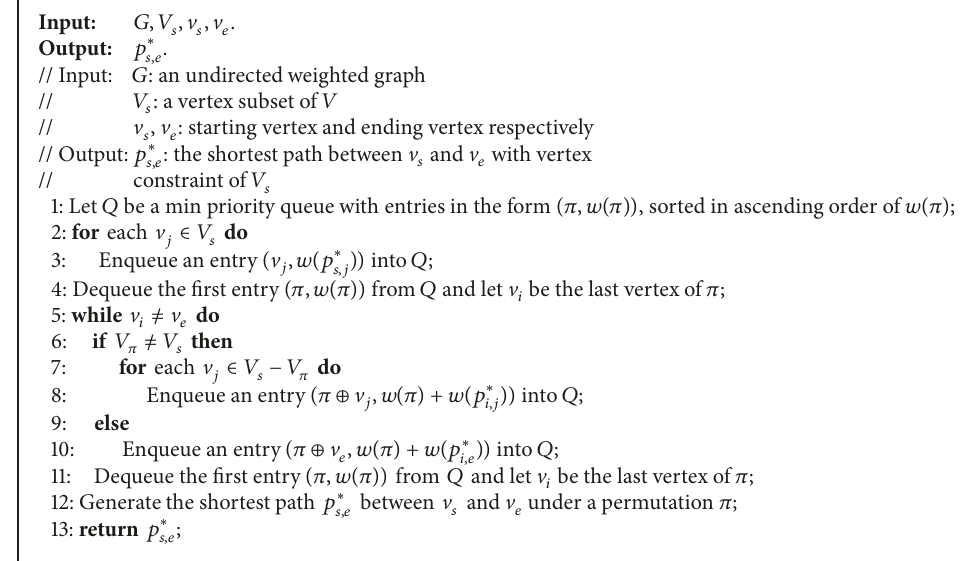
Algorithm 1: Permutation-Expanding ( 𝐺,𝑉 𝑠 , V 𝑠 , V 𝑒